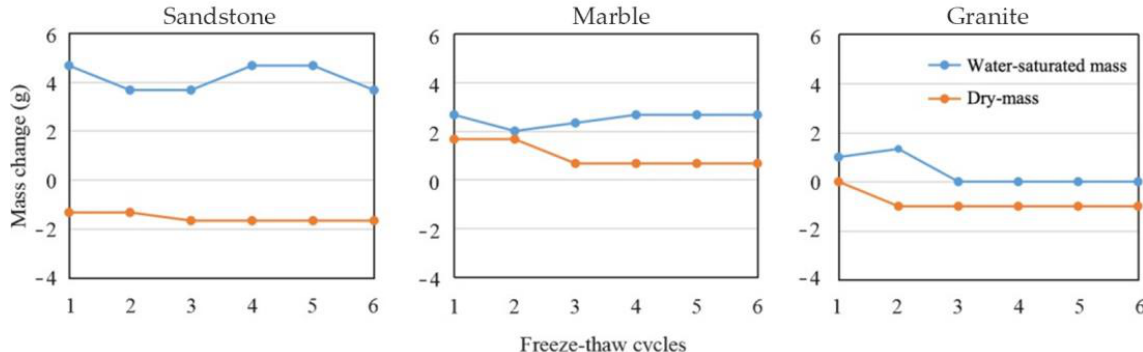
Figure 10. Mass change of three types of samples after different freeze–thaw cycles.